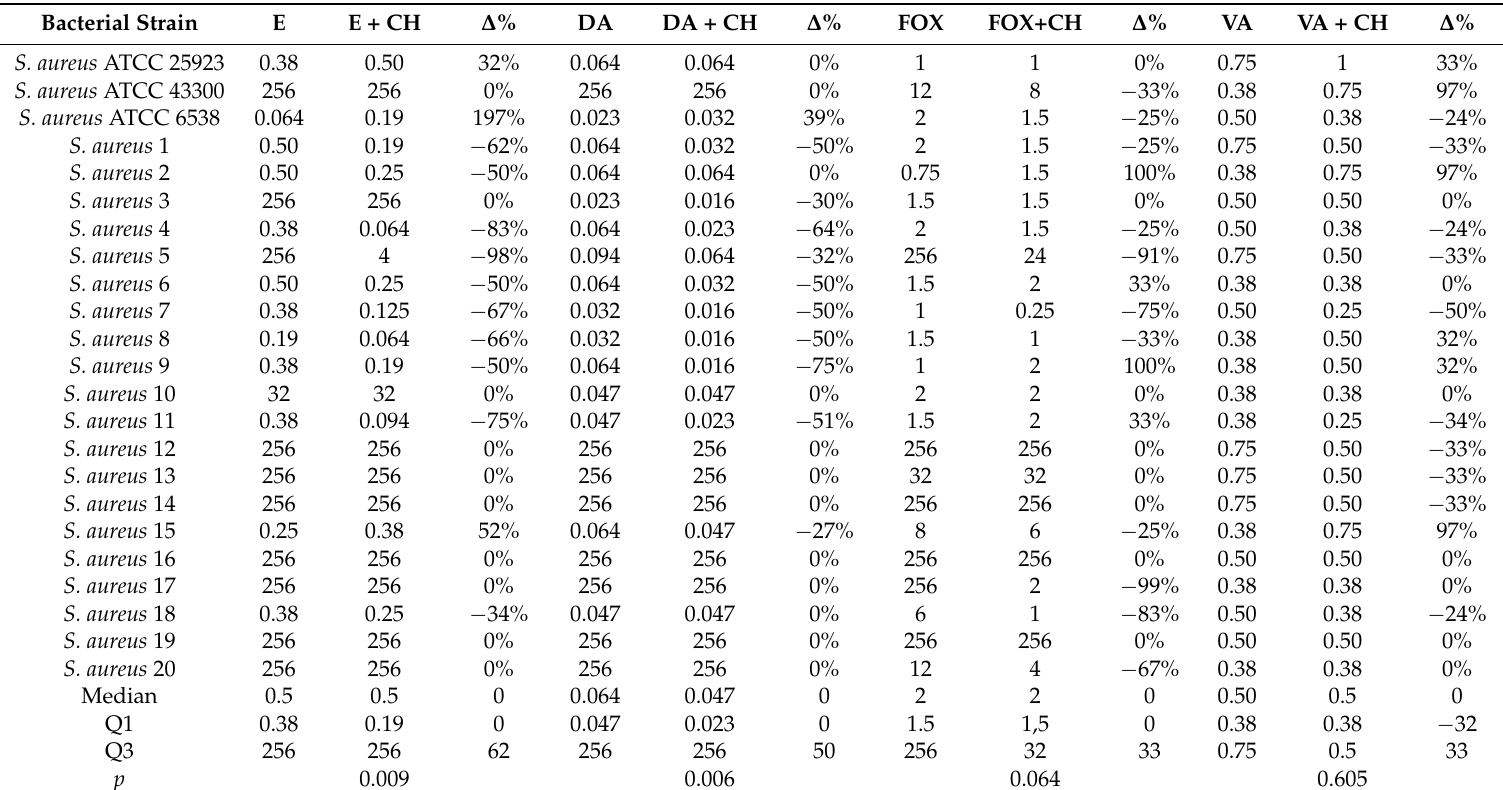
Table 2. The combined antibacterial effects of catechin hydrate and erythromycin, clindamycin, cefoxitin and vancomycin on Staphylococcus aureus examined strains (MIC values expressed in µ